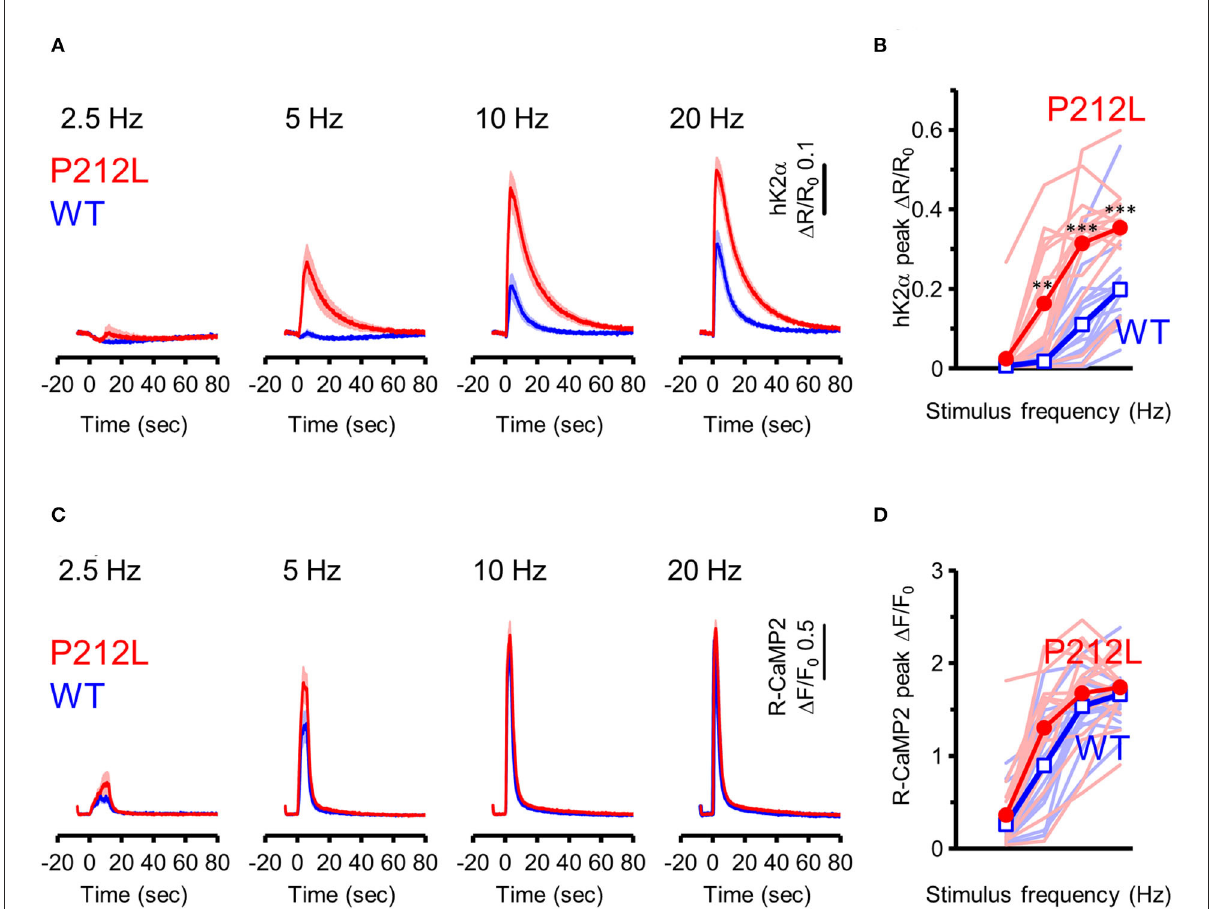
FIGURE4 P212L mutation shifted frequency-dependent CaMKII α activation curve toward lower stimulation frequencies. (A) hK2 α WT (blue) or P212L (red) response traces in response to glutamate uncaging (30 stimulations at 2.5, 5, 10, 20Hz). Mean ± s.e.m are shown, n = 16 for WT, n = 16 for P212L. (B) Comparison of hK2 α response peak amplitude between WT (blue open square) and P212L (red filled circle). Each shaded line represents data from each individual neuron. ** p < 0.01, *** p < 0.001, WT vs. P212L, repeated measures ANOVA followed by Tukey’s test, n = 16 for WT, n = 16 for P212L. (C) R-CaMP2 responses to 30 stimulations delivered at 2.5, 5, 10, 20Hz in neurons co-expressed with K2 α WT (blue) or P212L (red). Mean ± s.e.m are shown ( n = 16 for WT, n = 16 for P212L). (D) Comparison of R-CaMP2 response peak amplitude between WT (blue open square) and P212L (red filled circle). Each shaded line represents data from each individual neuron. n = 16 for WT, n = 16 for P212L.